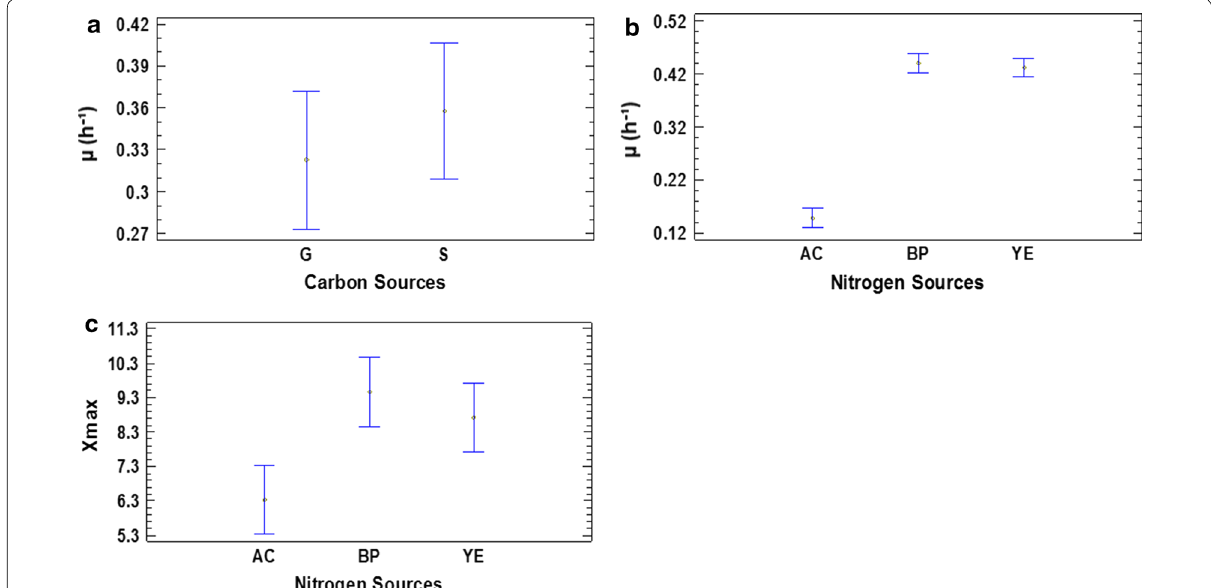
Fig. 1 Influence of carbon and nitrogen sources on µ and Xmax of P. indica H32. a Values of µ obtained with the evaluated carbon sources. b Values of µ obtained with the evaluated nitrogen sources. c Values of Xmax obtained with the evaluated nitrogen sources. G: glucose. S: sucrose. AC: ammonium chloride. BP: bacteriological peptone. YE: yeast extract. All bars represent the mean values